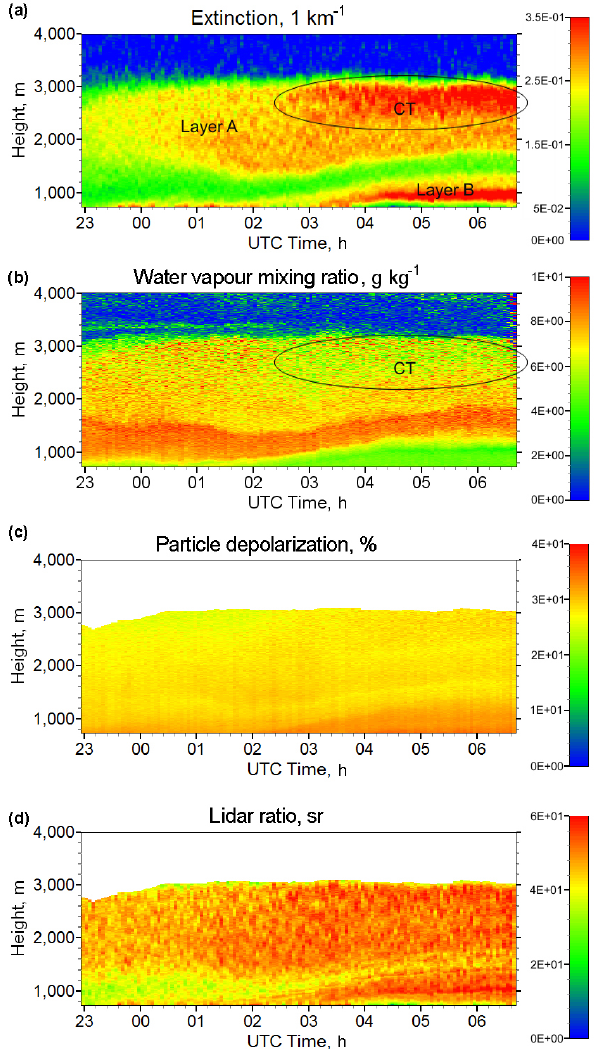
Figure 4. Height–temporal distribution of particle characteristics: (a) extinction coefficient α 532 , (b) water vapor mixing ratio, (c) par- ticle depolarization, and (d) lidar ratio LR 532 measured during the night of 15–16 April 2015.